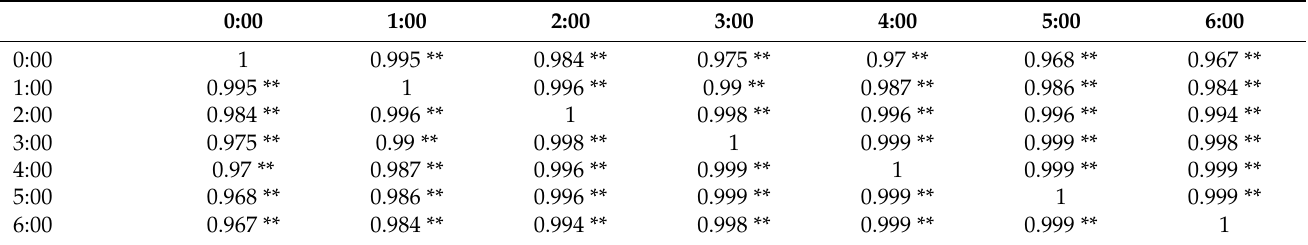
Table A3. Correlation coefficients of vitality between each two times in the sleeping